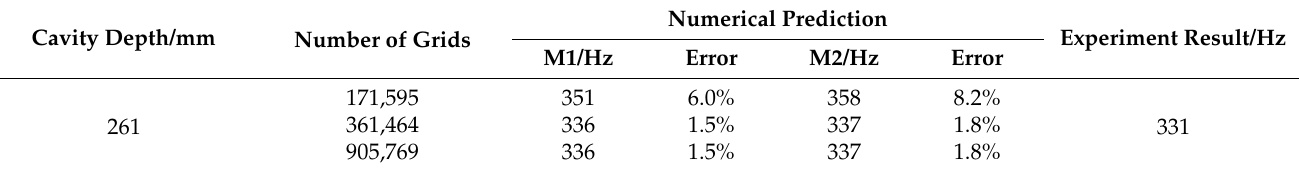
Table 1. Independence verification of grid.